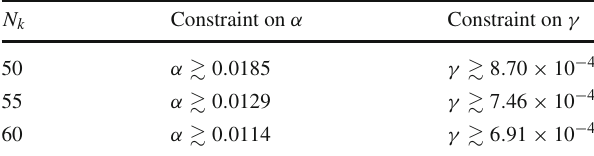
Table11 Resultsoftheconstraintsontheparameters α and γ forExpo- nential SUSY inflation in the high-energy limit of Randall–Sundrum brane model, using the last data of PLANCK N k